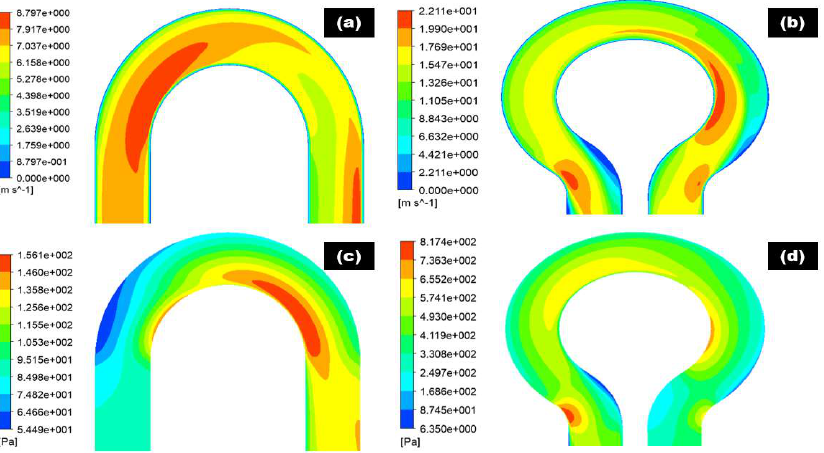
Figure 10. Contours of 180 ◦ U-bend and double offset U-bend for 6 m/s flow velocities: ( a , b ) velocity distribution; ( c , d ) wall shear stress.